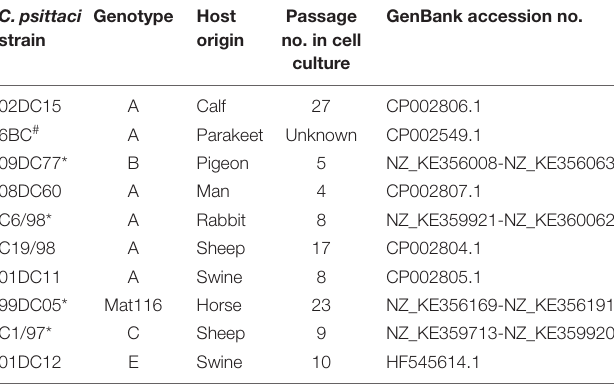
TABLE 1 | Summary of C. psittaci